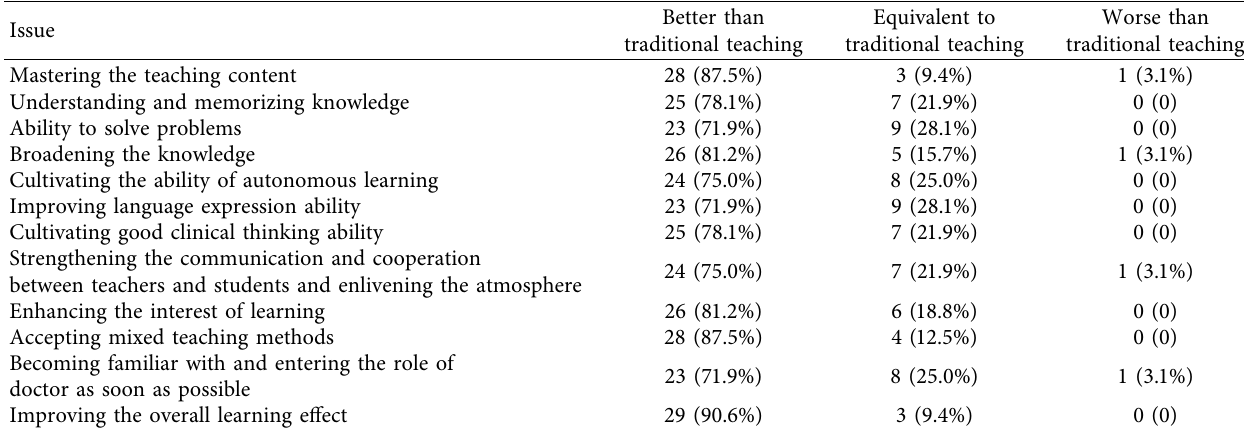
Table 5: Evaluation of the mixed teaching methods for clinical anesthesiology courses by 32 students in 2013 grade anesthesiology experimental group of Wenzhou Medical University ( N